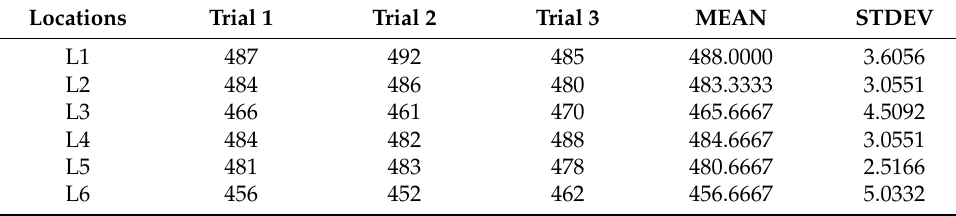
Table A3. Experimental data of temperature measurement at L1~L6 at the z -axis in Figure 9b.